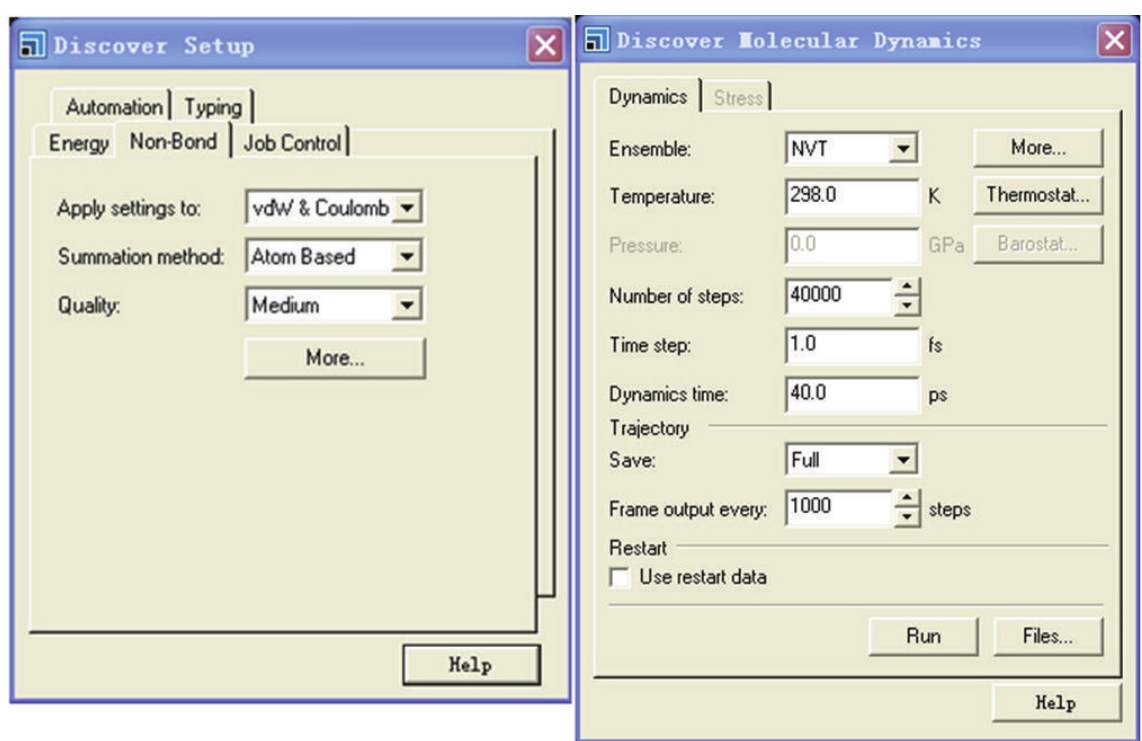
Figure 4: The details of the simulation parameters of system 1 for MD